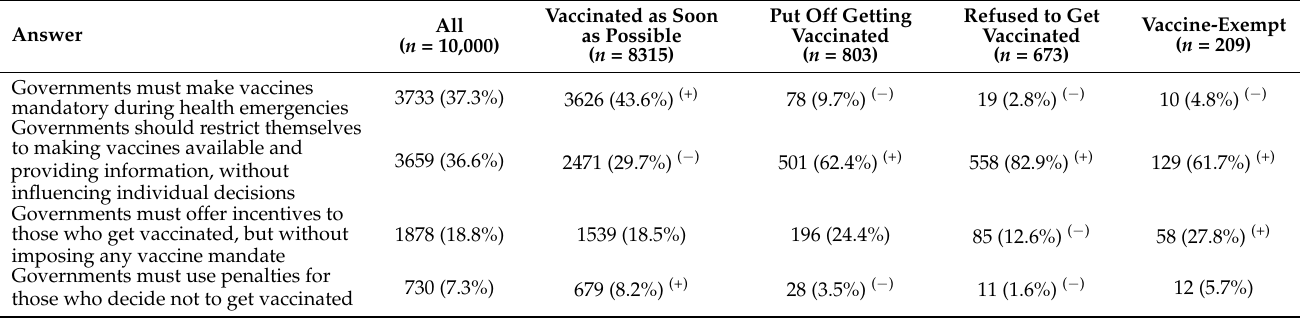
Table 3. Opinion on vaccination policies in the study sample, overall and COVID-19 vaccine up- take status. Counts and percentages were obtained by weighting all observed values with post- stratification weights based on the distribution of Italy’s resident adult population by NUTS region, gender, and age